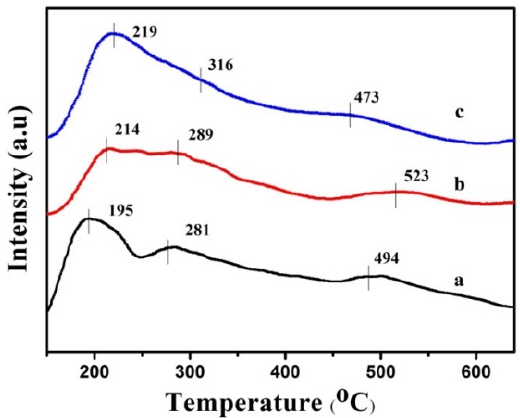
Figure 11. CO 2 ‐ TPD profiles of PtSn/Mg(Al)O with different Mg:Al ratios: ( a ) Mg:Al = 2:1; ( b ) Mg:Al = 5:1; ( c ) Mg:Al = 10:1.